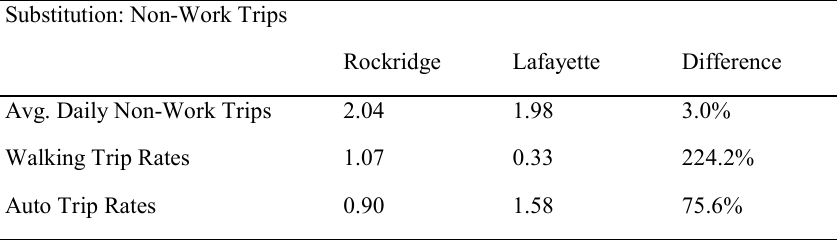
Table 2. Summary of Substitution Effects of Built Environments on Non-Work Trips Substitution: Non-Work